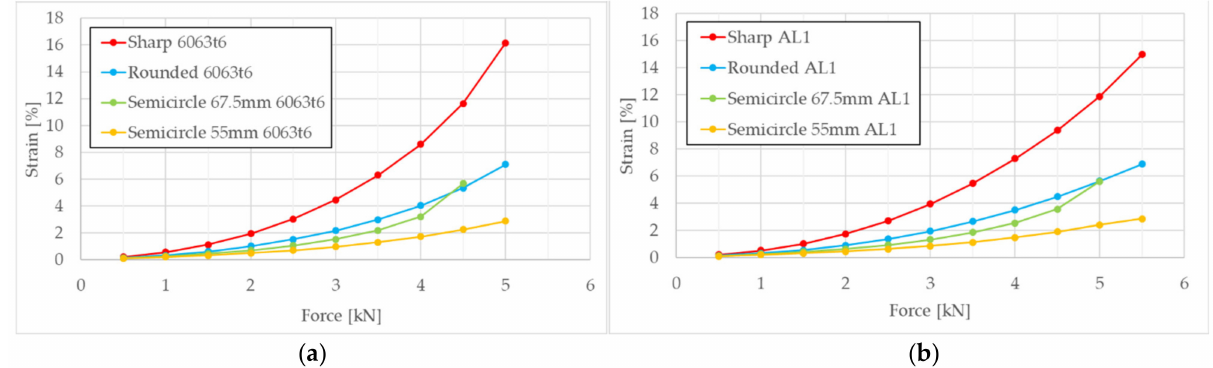
Figure 21. Strain-force curves for the ( a ) nominal and ( b ) true stress–strain curve.